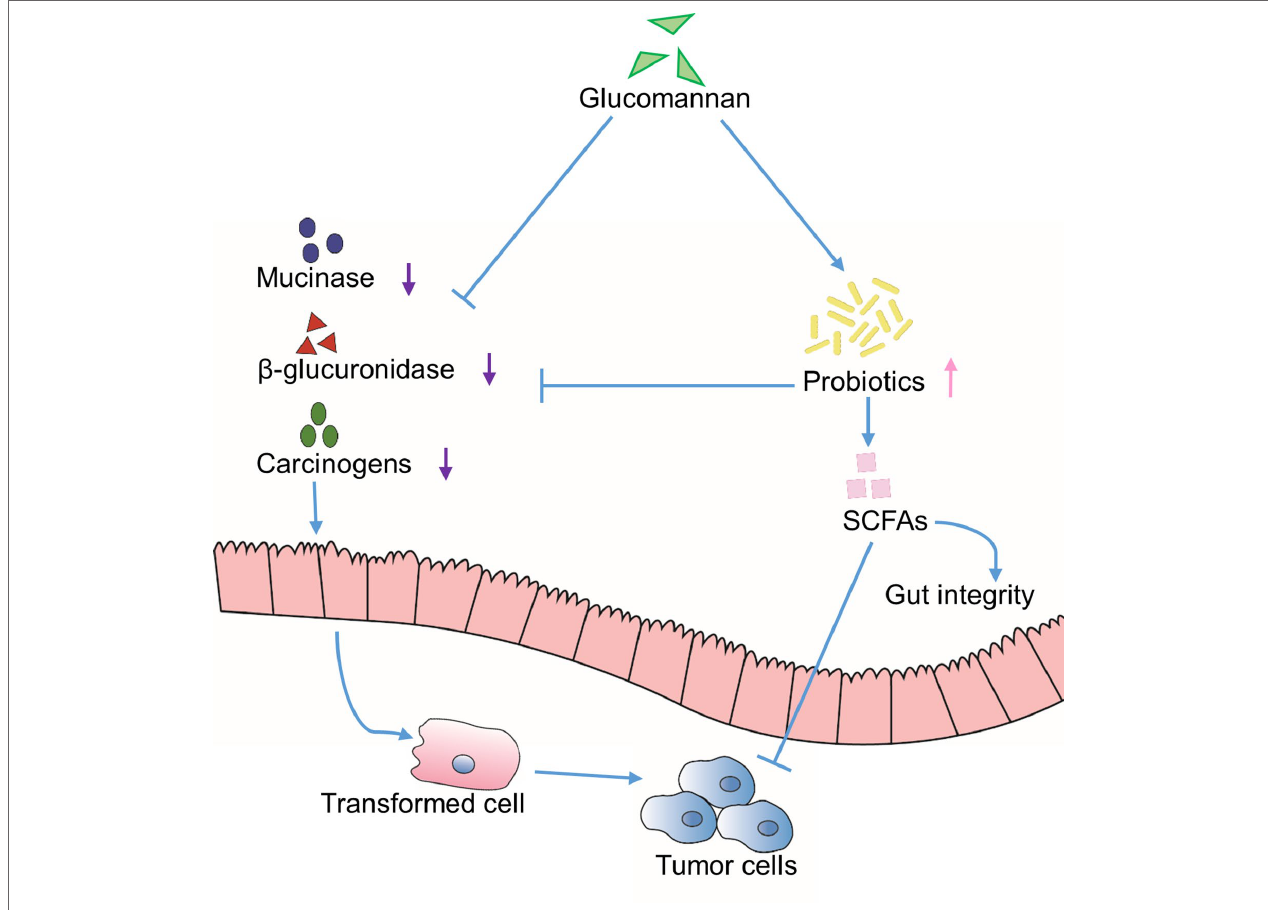
FIGURE 2 | Indirect effects through extrinsic environment. Inhibition of the activity of mucinase and β -glucuronidase is achieved through glucomannan or glucomannan-induced colonization of probiotics, which results in reduced carcinogens and increased SCFAs content in the gut lumen. Altogether, the tumor development is